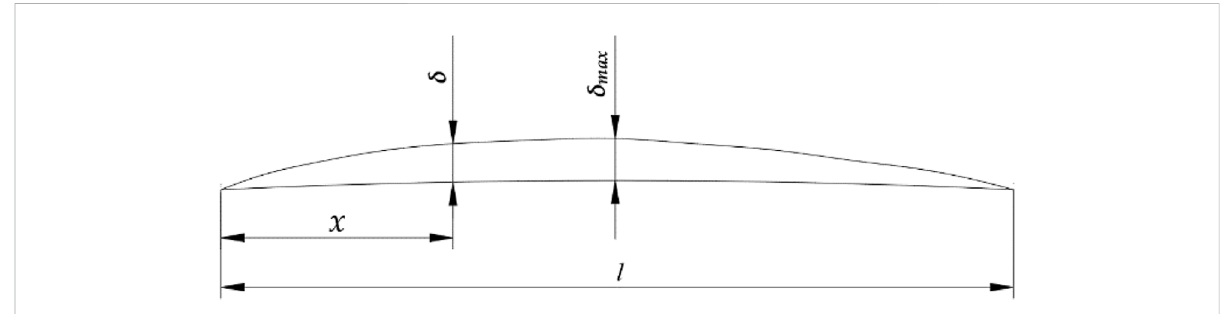
FIGURE 1 The 791 airfoil.